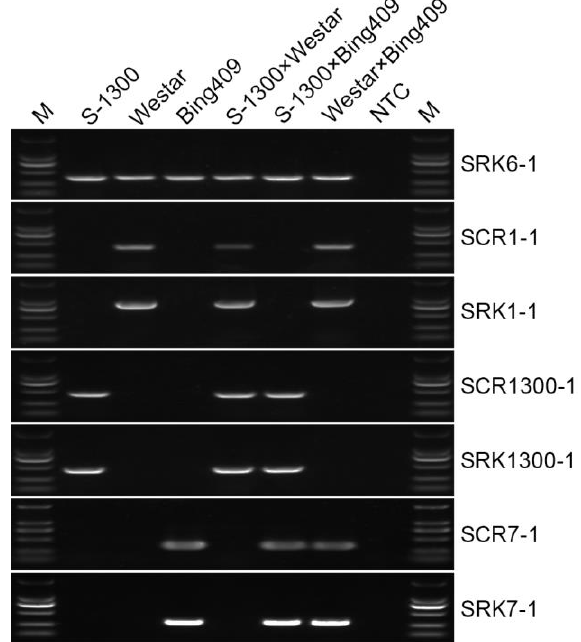
Figure 1. PCR fragment amplified and obtained from three kinds of parent materials and F 1 gener- ation of one-by-one pairs using SCAR markers. NTC: no template control. M: DNA marker, from top to bottom, the size of band was 2000, 1000, 750, 500, 300, and 200 bp, respectively. To verify the effect of the SI-related SCAR molecular markers, the ‘ S-1300 ’ line was crossed as the female parent with 14 self-compatible inbred lines to produce 14 F 1 gener- ation hybrids. First, the marker SRK6-1 [23] was verified in these self-compatible lines. As shown in Table 1 and Figure S2, all these materials contained the SRK6-1 products, indi- cating that the S haplotypes in the C subgenome of all these lines were BnS-6 or BnS-6- like . Then, the markers of BnS-1300 , BnS-1 , and BnS-7 were tested in these 14 lines. In the A subgenome of ‘ Westar ’ , ‘ Huangshuang2 ’ , ‘ Tapidor ’ , and ‘ 89008 ’ , the S haplotype was BnS-1 , while in the A subgenome of ‘ Ningyou-7 ’ , ‘ 326 ’ , ‘ 614 ’ , ‘ 1728 ’ , ‘ C32 ’ , ‘ Bing409 ’ , ‘ 242 ’ , ‘ 198 ’ , ‘ 1745 ’ , and ‘ 230 ’ , the S haplotype was BnS-7 (Table 1). To further confirm whether the genotype was associated with the SI phenotype, the F 1 plants were self-pollinated and the SC Index (SCI) of F 1 plants of ‘ Westar ’ , ‘ Huangshuang2 ’ , ‘ Tapidor ’ , and ‘ 89008 ’ were crossed with ‘ S-1300 ’ ranging from 17.68 to 21.06, which were presented as the SC pheno- type. The SCI of F 1 plants of the other ten lines crossed with ‘ S-1300 ’ ranged from 0.02 to 0.64, which were presented as the SI phenotype (Table 1). These results indicated that these SCAR markers were able to identify the S haplotype in B. napus . The S -locus was found to widely exist in B. napus lines, however, the distribution of S haplotypes in B. napus natural population was still unclear. We then investigated the Table 1. Genotypes of the 14 B. napus lines collected and the phenotypes of the corresponding F 1 hybrids. S -locus in 523 B. napus inbred lines and cultivars using the present SCAR markers. In 523 B. napus inbred lines, 239 lines contained BnS-1 (45.70%); 226 lines contained BnS-7 (43.21%); Material and only 3 lines (‘11-P63-5Y7’, ‘11-P63-8Y32’, and ‘11-P63-3Y3’) contained BnS-1300 . Inter- estingly, 20 lines contained the BnS-1 and BnS-7 haplotypes simultaneously, suggesting that more than one S -locus could exist in the A subgenome of these B. napus lines. There were also 35 cultivars that could not be detected in any mentioned S haplotypes, indicating that there were other S haplotypes in these 35 cultivars. We also tested the S haplotype in the C subgenome and the results indicated that all 523 lines were BnS-6 (Tables 2 and S2). Obviously, these 239 BnS-1/BnS-6 cultivars and 226 BnS-7/BnS-6 cultivars could be used as restorer and maintainer lines for ‘S-1300’ in SI-related breeding,